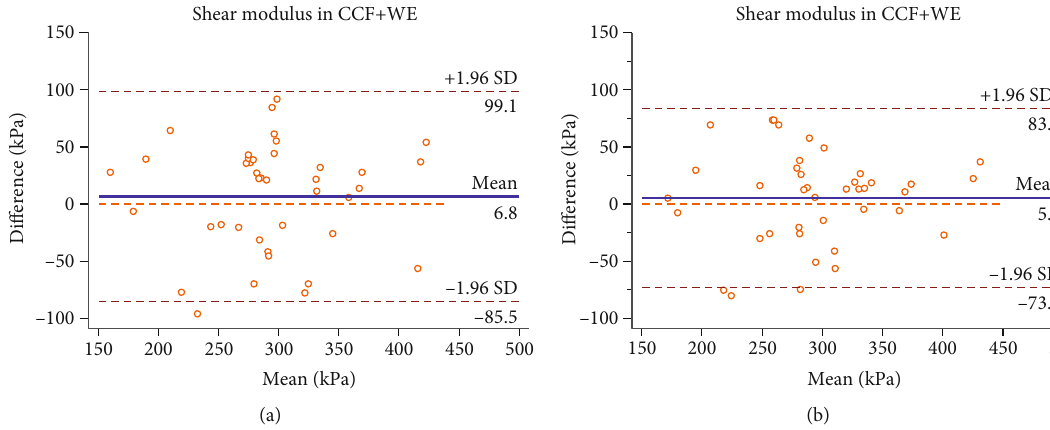
Figure 3: Bland-Altman plots of intra- and interoperator reliabilities for the shear modulus of the median nerve in the contralateral cervical fl exion+wrist extension (CCF+WE). Intraoperator reliability (a): the di ff erence in median nerve sti ff ness between day 1 and day 5 is plotted against mean median nerve sti ff ness (average of the 2 days for operator A) for each subject. Interoperator reliability (b): the di ff erence in median nerve sti ff ness between operator A and operator B is plotted against mean median nerve sti ff ness (average of the 2 operators) for each subject. The continuous lines represent the mean di ff erence, while the dotted lines show the 95% upper and lower limits of